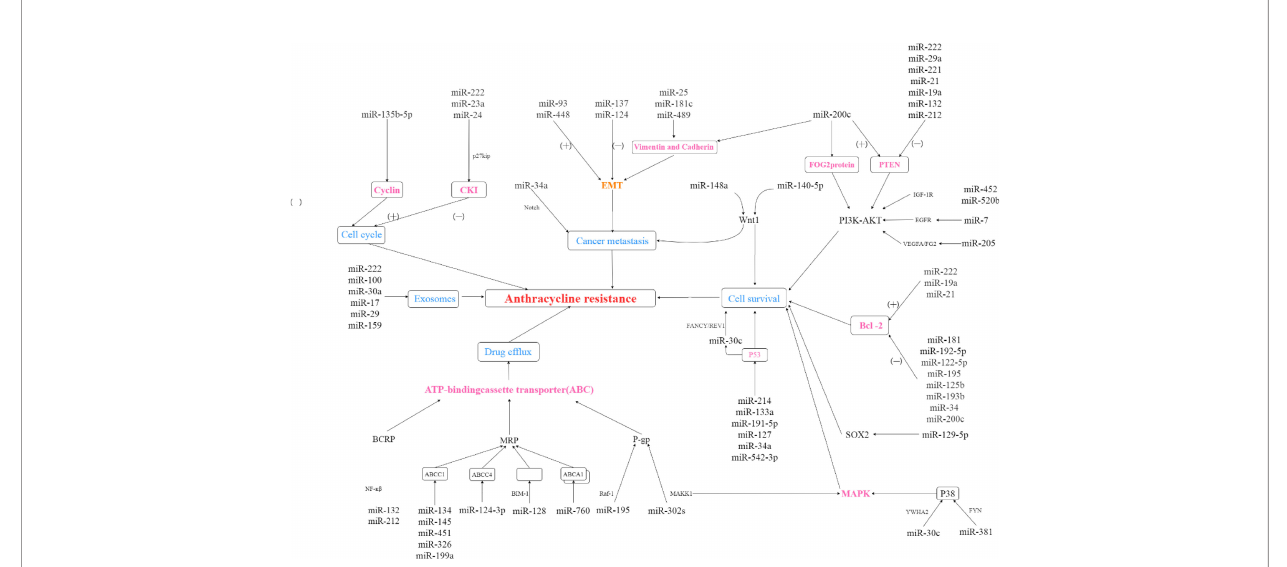
FIGURE 1 | The role of miRNAs in anthracyclines resistance. (+): microRNA promotes expression of dowmstream protein; (-): microRNA suppresses expression of dowmstream